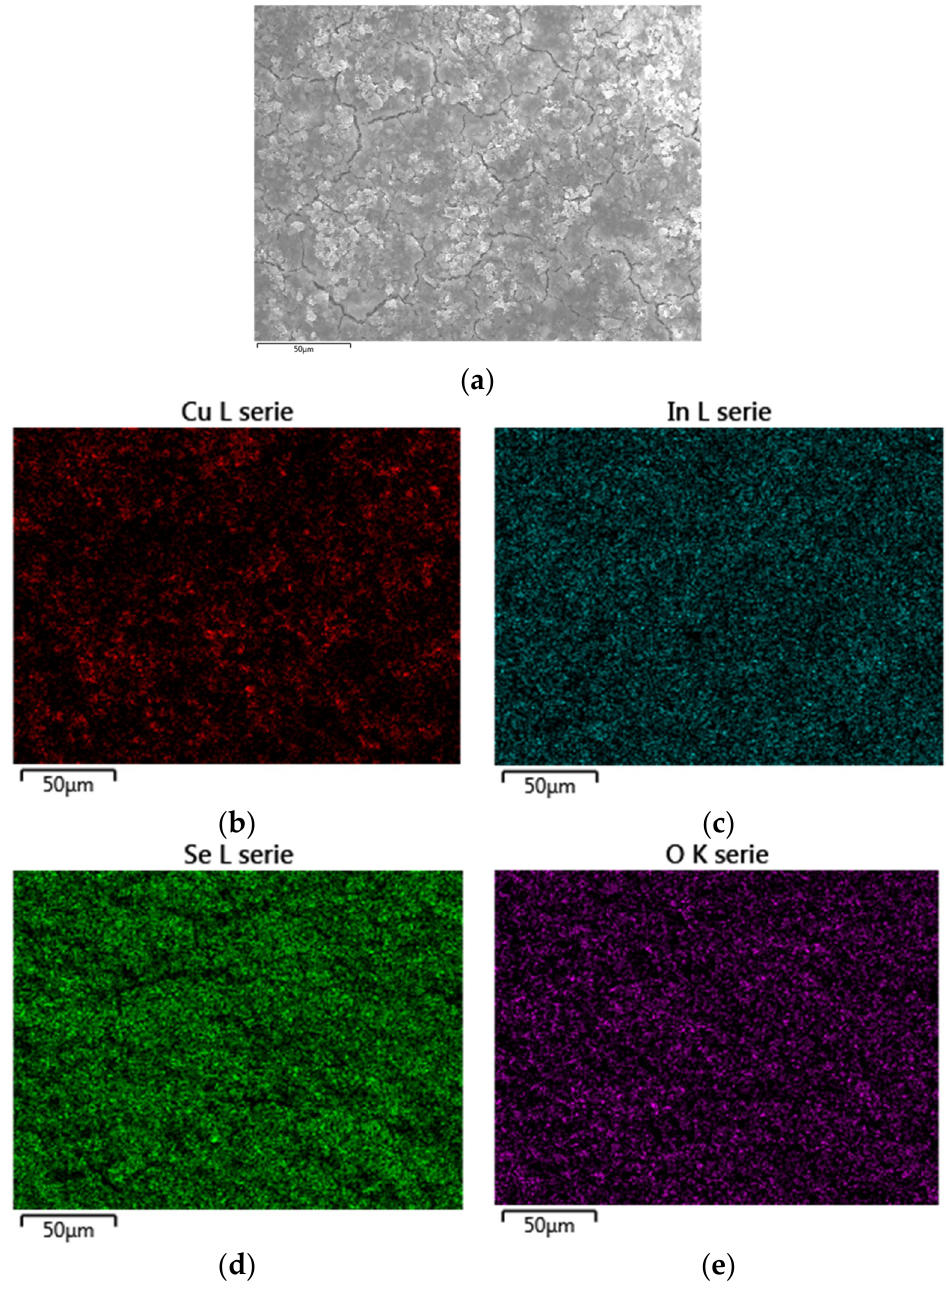
Figure A4. EDX mapping ( a ) of ethanol based route II CISe film shows an evenly distributed elemental composition of Cu: 18.6 at % ( b ); In: 20.3 at % ( c ); Se: 43.5 at % ( d ); O: 17.5 at % ( e ).